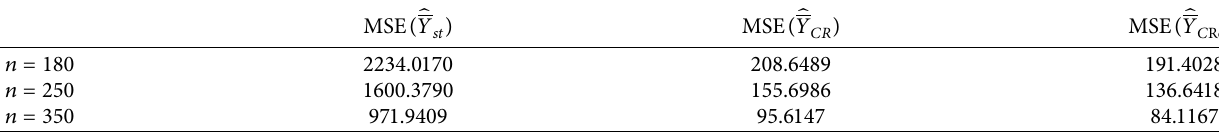
, 􏽢 Y , and 􏽢 Y st CR CReg for different sample sizes.